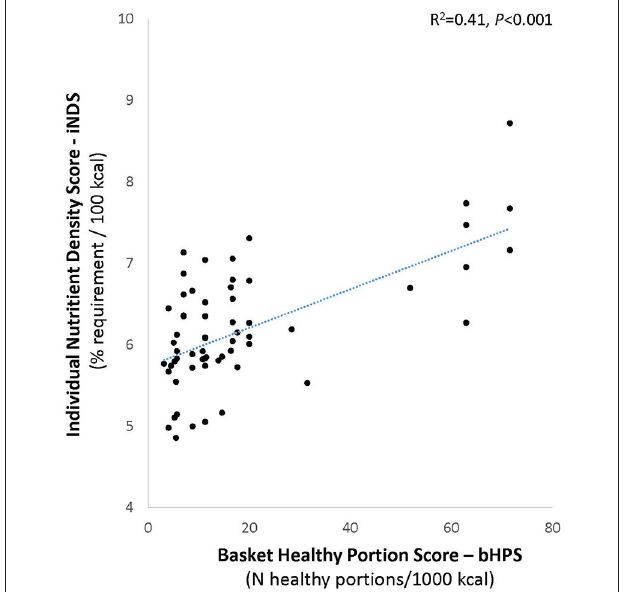
FIGURE 5 | Relation between food aid quality and the quality of individual aid recipient diet. Chart shows unstandardized predicted individual nutrient density scores (iNDS) predicted by basket healthy portion scores (bHPS) in regression adjusted for gender, marital status, and country of